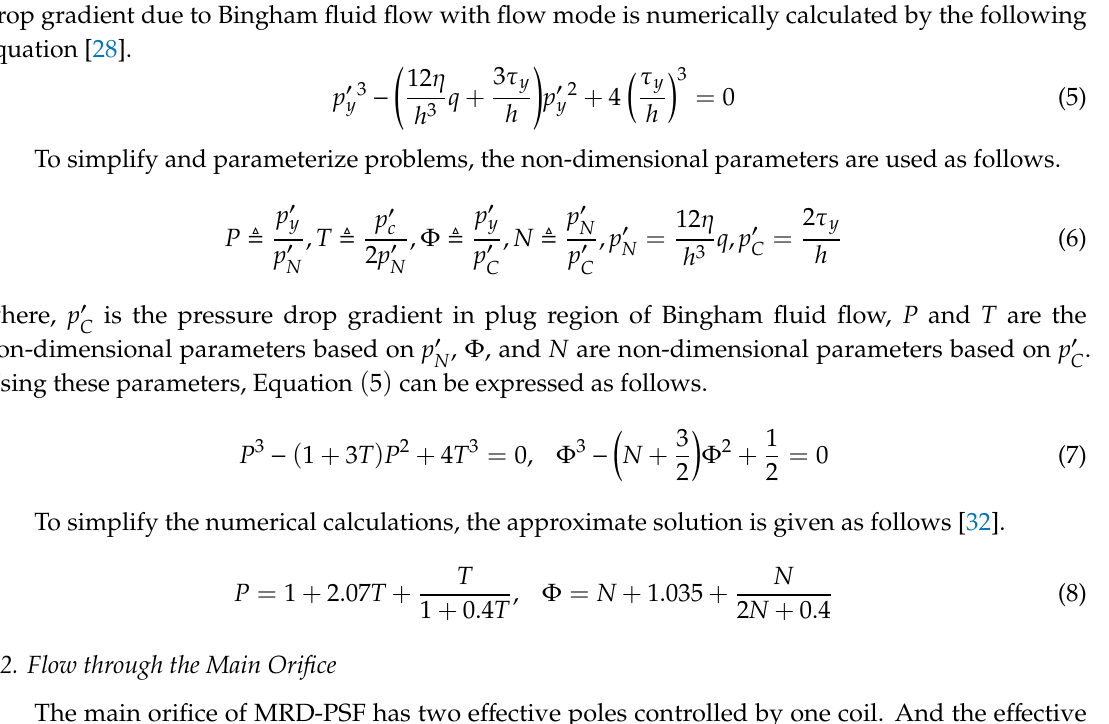
Figure 9. Mean velocity profile of MR fluid in orifice.